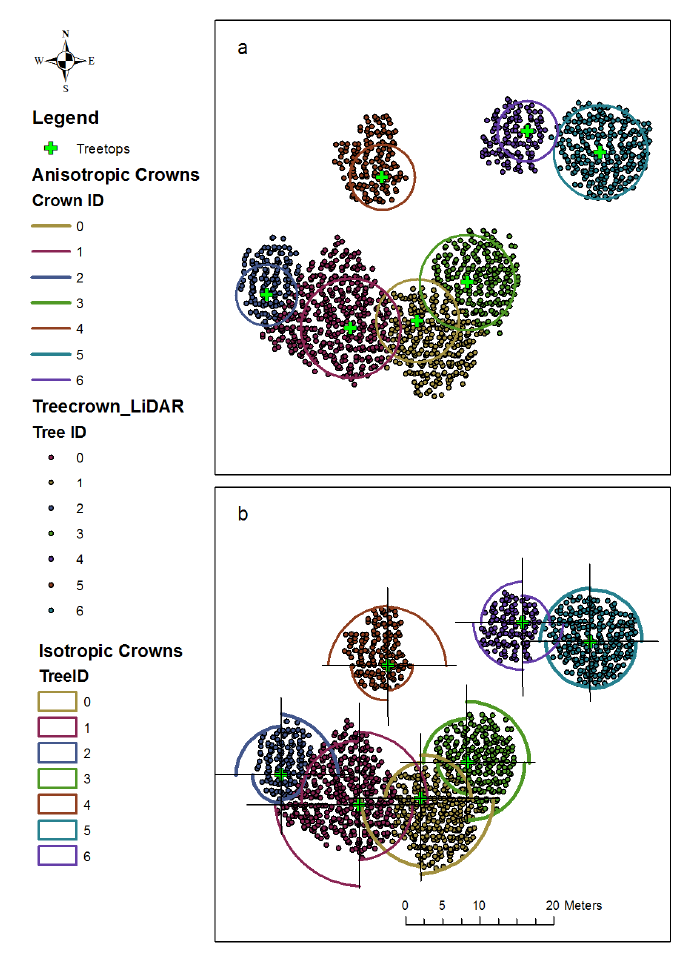
Figure 7. Defined crown boundary and extracted individual trees for a portion of the study area from ( a ) the isotropic and ( b ) anisotropic donut expanding and sliding method